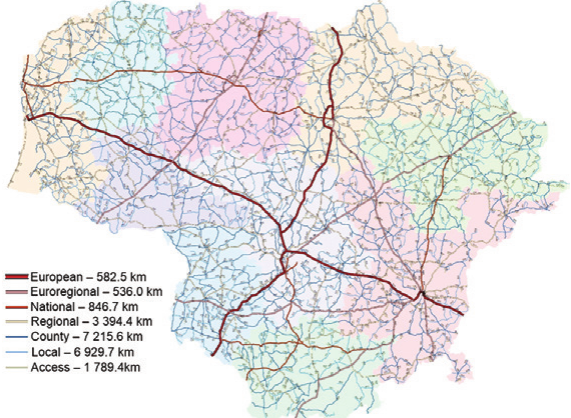
Fig. 5. Road network breakdown into categories according to the functional purpose (VGTU Road Research Institute scientific report Functional analysis of the road network elements and preparation of the development scheme